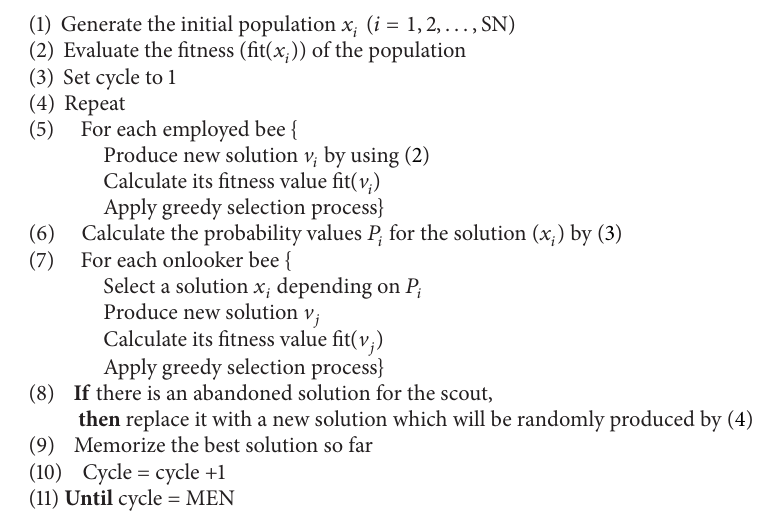
Algorithm 1: Pseudocode of main body of ABC